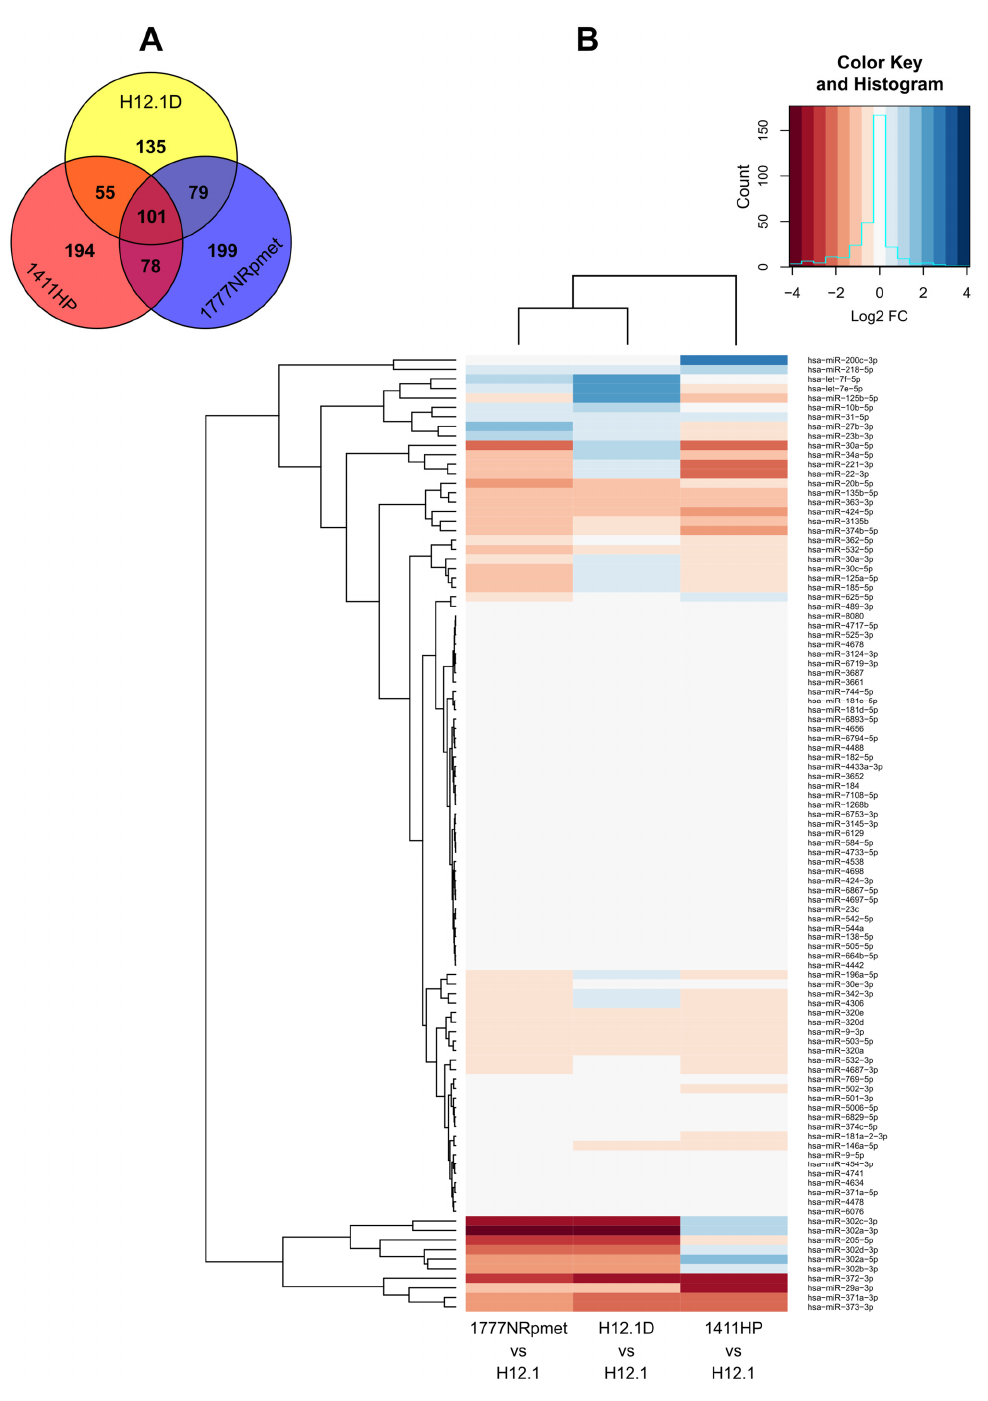
Figure 2. Venn diagram and heatmap of overlapping miRNAs in CDDP-resistant TGCT cell lines. Venn diagram analysis of three CDDP-resistant cell lines (H12.1D, 1411HP and 1777NRpmet) reveals 101 miRNAs whose expression significantly changed ( p < 0.05) in all three TGCT cell lines when compared to the CDDP-sensitive TGCT cell line H12.1. miRNAs with common changes in expression are presented as overlaps between the three analysed TGCT cell lines. Red colour represents 1411HP, blue represents 1777NRpmet and yellow represents the H12.1D TGCT cell line ( A ). The heatmap illustrates 101 common differentially expressed miRNAs with log 2 transformed mean FC ( p < 0.05) in CDDP- resistant TGCT cell lines in comparison with the CDDP-sensitive TGCT cell line H12.1. Red colour indicates decreased relative expression, and blue colour indicates increased relative expression ( B